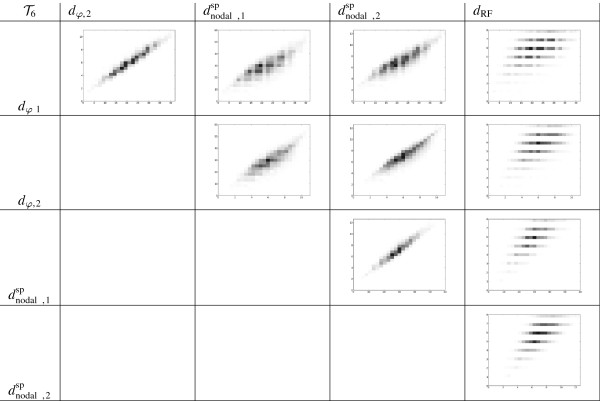
2D-histograms showing the relationship between different distances onT6.